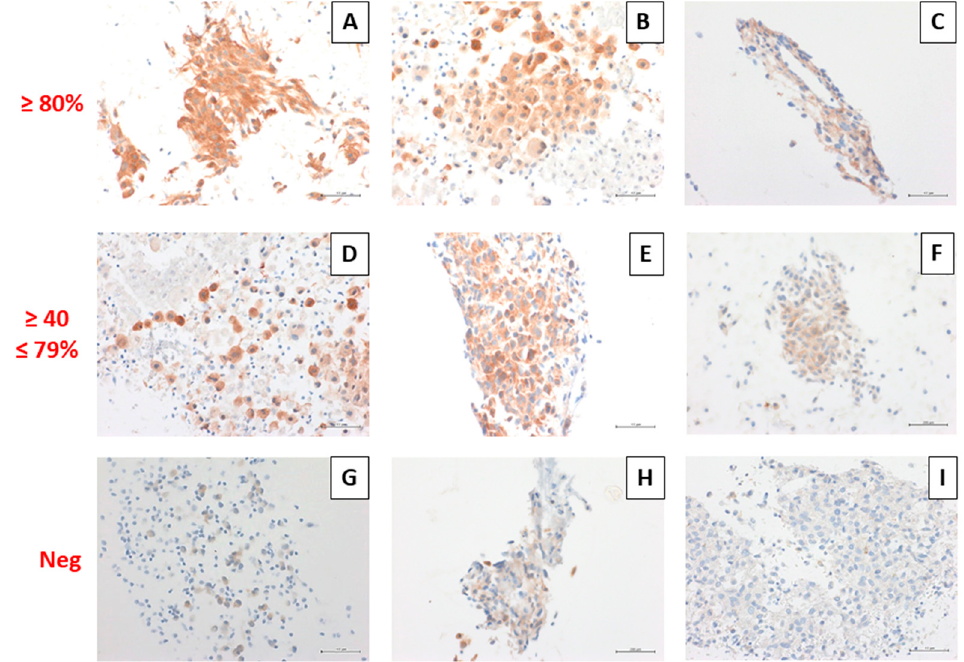
Figure 3. Overview of BRAF V600E immunocytochemistry on CB sections. Granular cytoplasmic positivity with different intensity of the immunocytochemical signal: strong intensity ( A , D ), moderate intensity ( B , E ), slight intensity ( C , F ) in over 80% of the neoplastic cells ( A – C ) and between 40 and 79% of the neoplastic cells ( D – F ) Negative cases ( G – I ). (Immunocytochemical stains, original magnification 400×) .